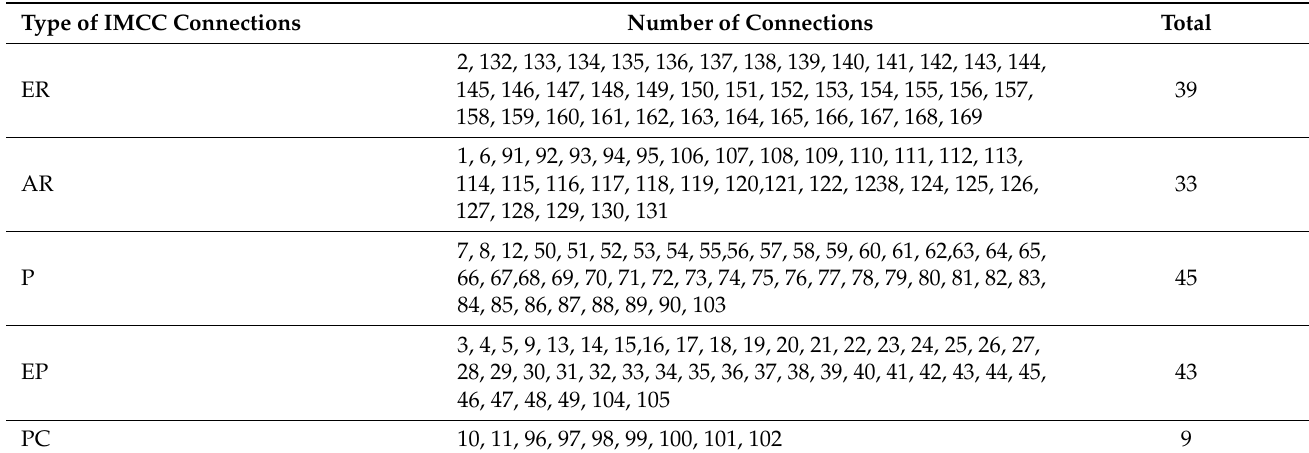
Table 1. Intra-mathematical questionnaire connections (QC) identified in study 1.